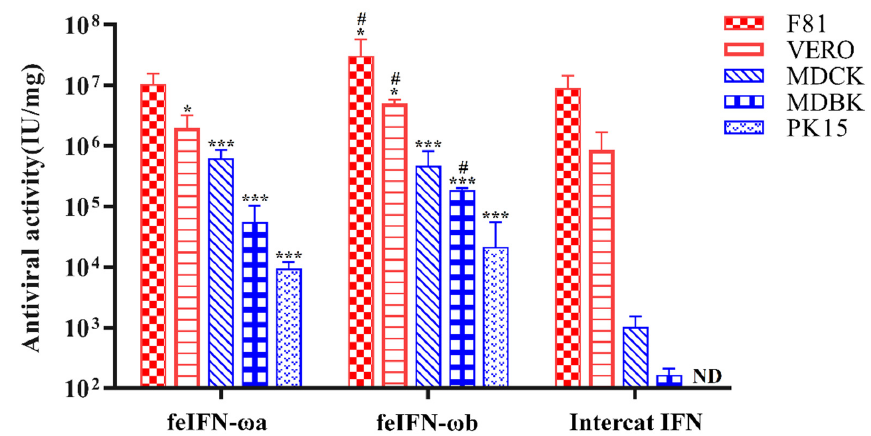
Figure 6. The species-specific antiviral activities of rfeIFN- ω a and rfeIFN- ω b using INTERCAT IFN for comparison. Bars represent the mean ± SEM for each group. Significant differences (* p < 0.05; *** p < 0.001) were observed when comparing the rfeIFN- ω a/rfeIFN- ω b groups to the INTERCAT IFN group. Comparison of the rfeIFN- ω b group and rfeIFN- ω a group also indicated significant differences (# p < 0.05).